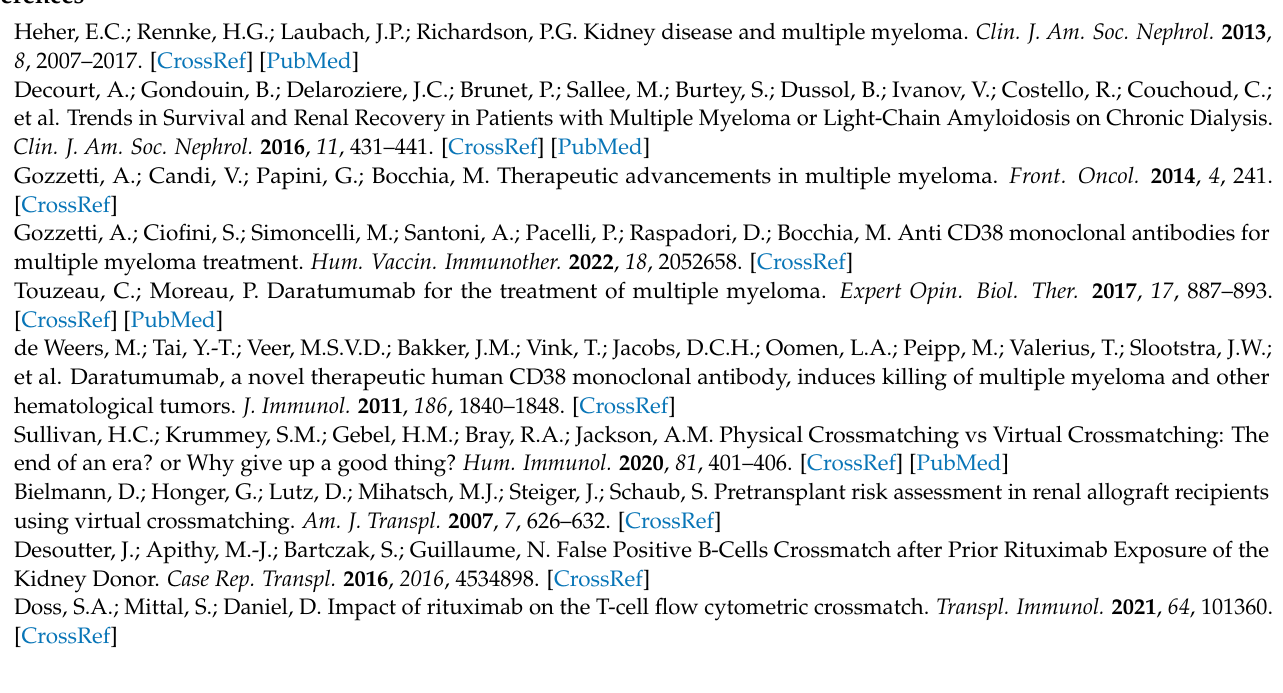
Table S2: Impact of DTT concentration and incubation time on CD38 expression; Table S3: Surrogate crossmatch with DTT-treated cells and DTT-treated sera; Table S4: Autologous crossmatch; Figure S1: Representative Luminex HLA antibody